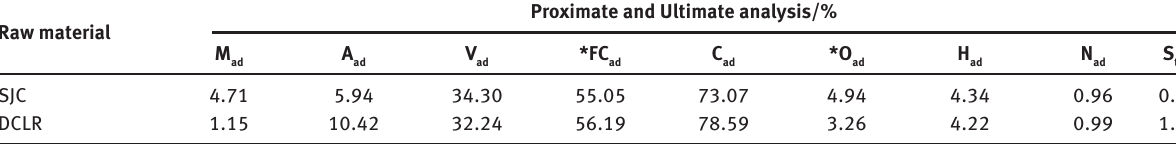
Table 1: Proximate and ultimate analysis of SJC and DCLR.